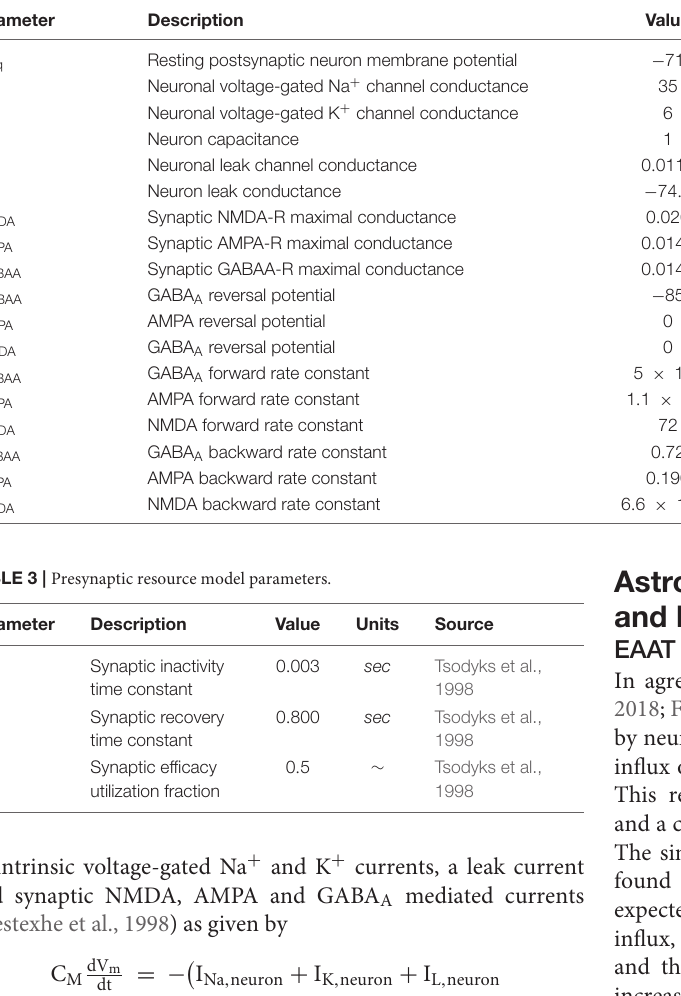
TABLE 2 | Neuronal membrane model parameters.